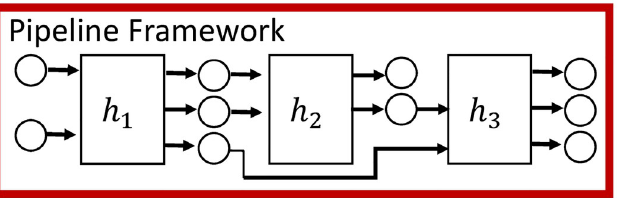
Fig 9. Conceptual view of a pipeline that is composed of the pipeline framework (represented by the bounding box) and the h -functions that provide the application-based functionality of a particular pipeline. Functions, or h - function, h , 1 � i � 3 are implemented as software within a pipeline. The pipeline framework (red box) controls the i execution order of functions and the inputs and outputs for each function, through a pipeline job specification. Circles in the figure denote input and output digital objects, such as ASCII files or database tables. This figure is a more detailed representation of Fig 4. Adapted from [34] Fig 3.